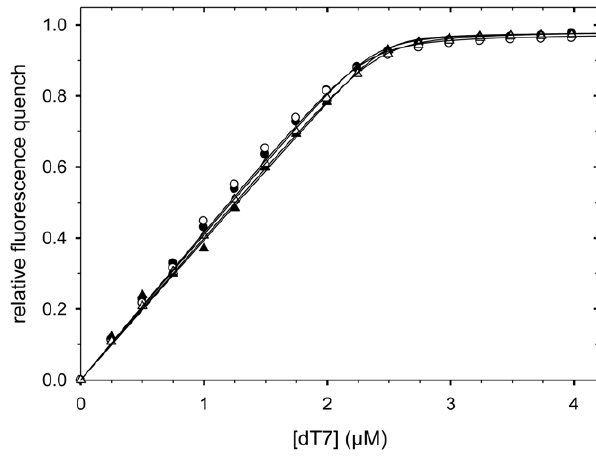
Figure 3. Nucleic acid binding of CspB. Binding of dT7 to the fusion proteins: Variants with 10 alanines are shown with filled symbols; variants with 17 alanines with open symbols; variants with a linker of 3 amino acids are shown as circles; variants with a linker of 16 amino acids as triangles. The corresponding K D values are listed in Table 1. Measurements were carried out in 5 mM KH 2 PO 4 , 100 mM NaCl, pH 7.5 at 20 u C.